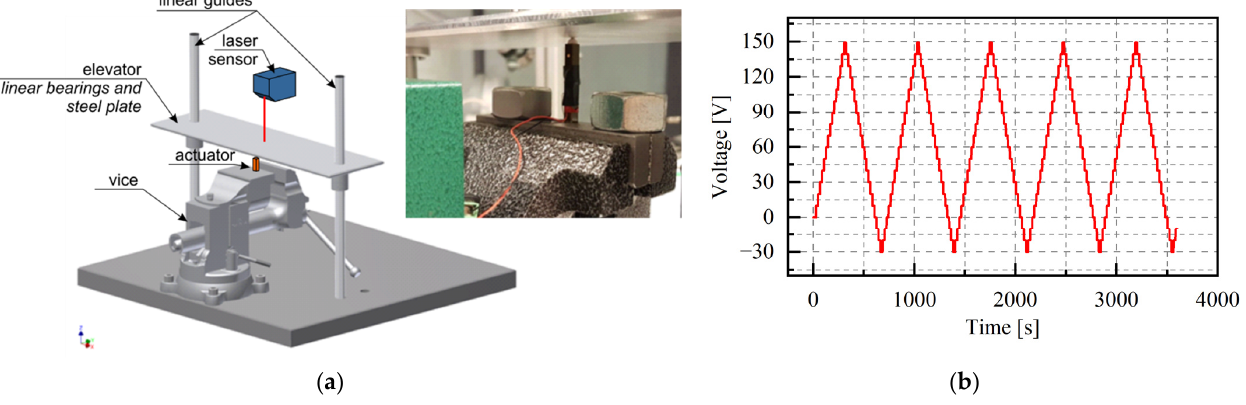
Figure 4. Experimental set-up used in piezoelectric research: ( a ) photo of the tested actuator placed between the vice and the measuring lift; ( b ) control signal voltage versus time.